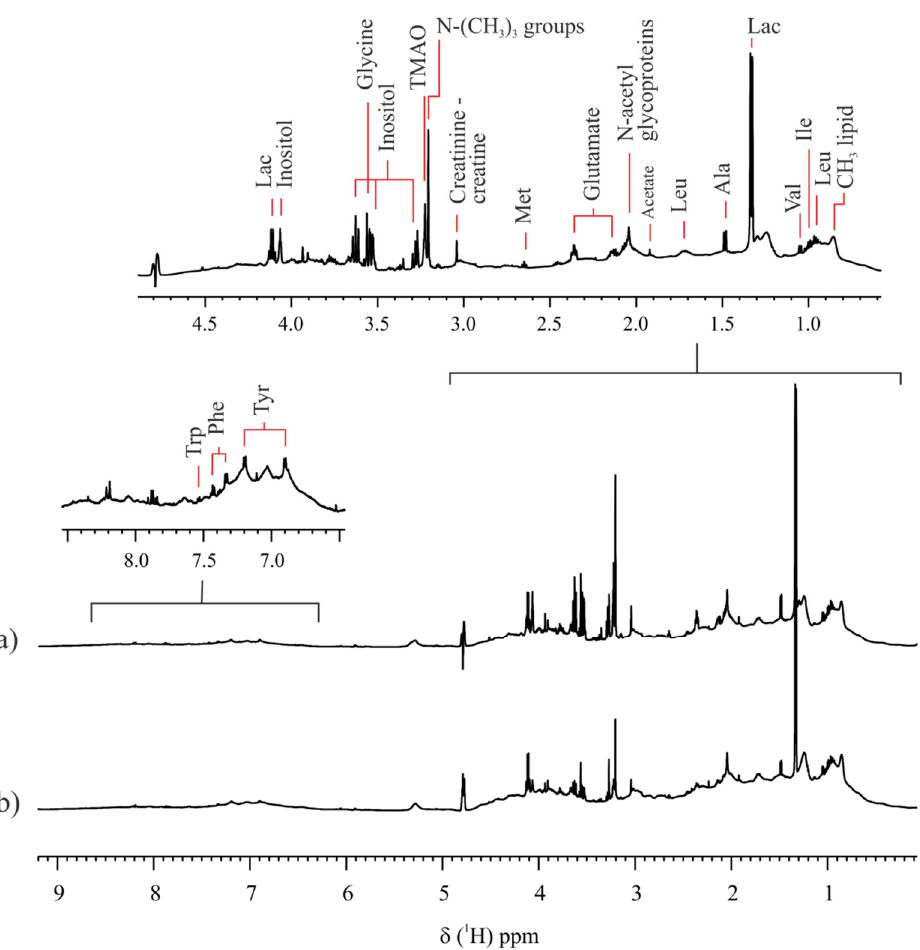
Figure 3. Representative 1H NMR spectra of follicular fluid samples of prepubertal goats collected from ( a ) small and ( b ) large follicles. Spectra were acquired at 298.0 K and at a magnetic field of 600 MHz, with suppression of the residual water signal.